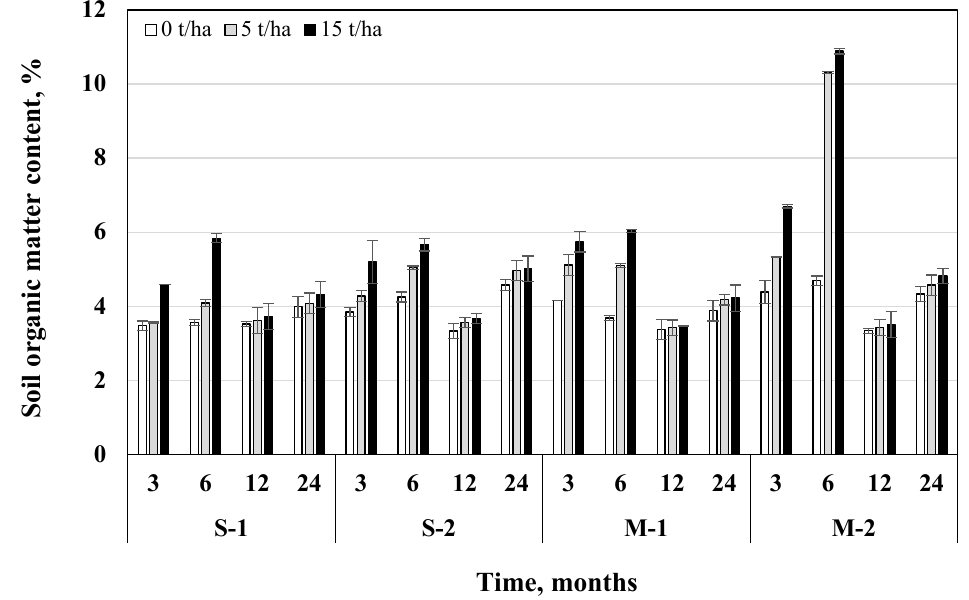
Figure 5. Influence of biochar on the amount of organic matter in different tillage-fertilization systems (S—ploughless shallow tillage, M—direct drilling, 1—unfertilized, 2—fertilized) after 3, 6, 12, and 24 months from the beginning of the experiment, n = 2.